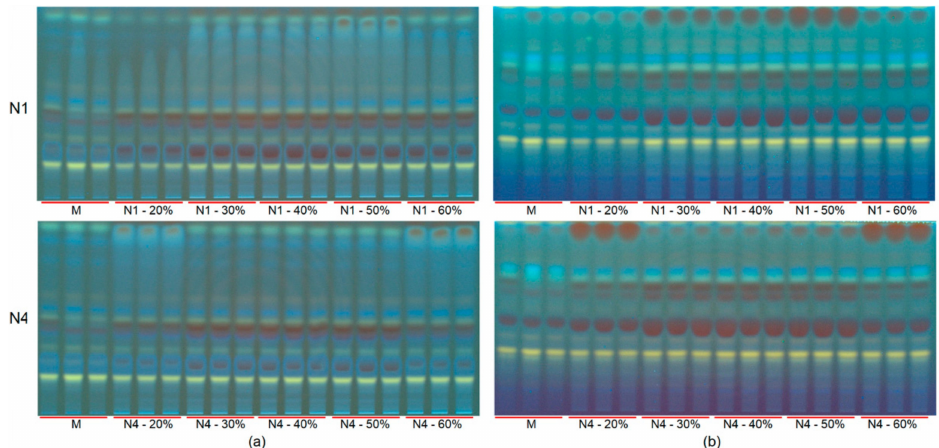
Figure 4. High-performance thin-layer chromatograms (HPTLC) of extracts of S. baicalensis bark obtained with 80% methanol in water and two NADES with di ff erent concentrations of water visualized at 366 nm after derivatization with natural products reagent (NPR) with two di ff erent mobile phase conditions. ( a ) Chromatogram obtained with mobile phase: ethyl acetate, methanol, formic acid, water (EMFW, 20:2.7:0.5:2, ratio v / v / v / v ); ( b ) Chromatogram obtained with mobile phase: ethyl acetate, formic acid, acetic acid and water (EFAW, 100:11:11:27, v / v / v / v ). M: 80% aqueous methanol ( v / v ), N1-20: mole / mole) with the addition of 30% ( w / w ), N1-40: citric acid– β -alanine (1:1, mole / mole) with the